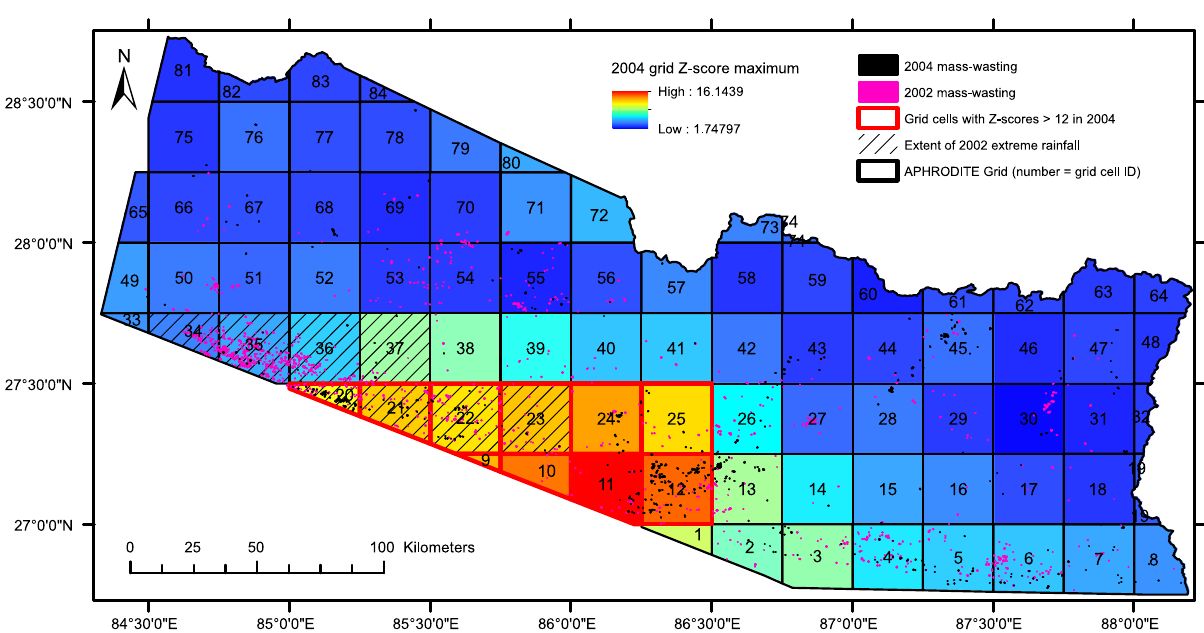
Fig. 6 The locations and IDs of the 84 APHRODITE rainfall grid cells across the study region. Maximum Z -scores from the 2004 monsoon seasons are depicted alongside the 2004 mass-wasting. Also shown is the extent of the 2002 extreme rainfall, and the mass-wasting from 2002 across the study